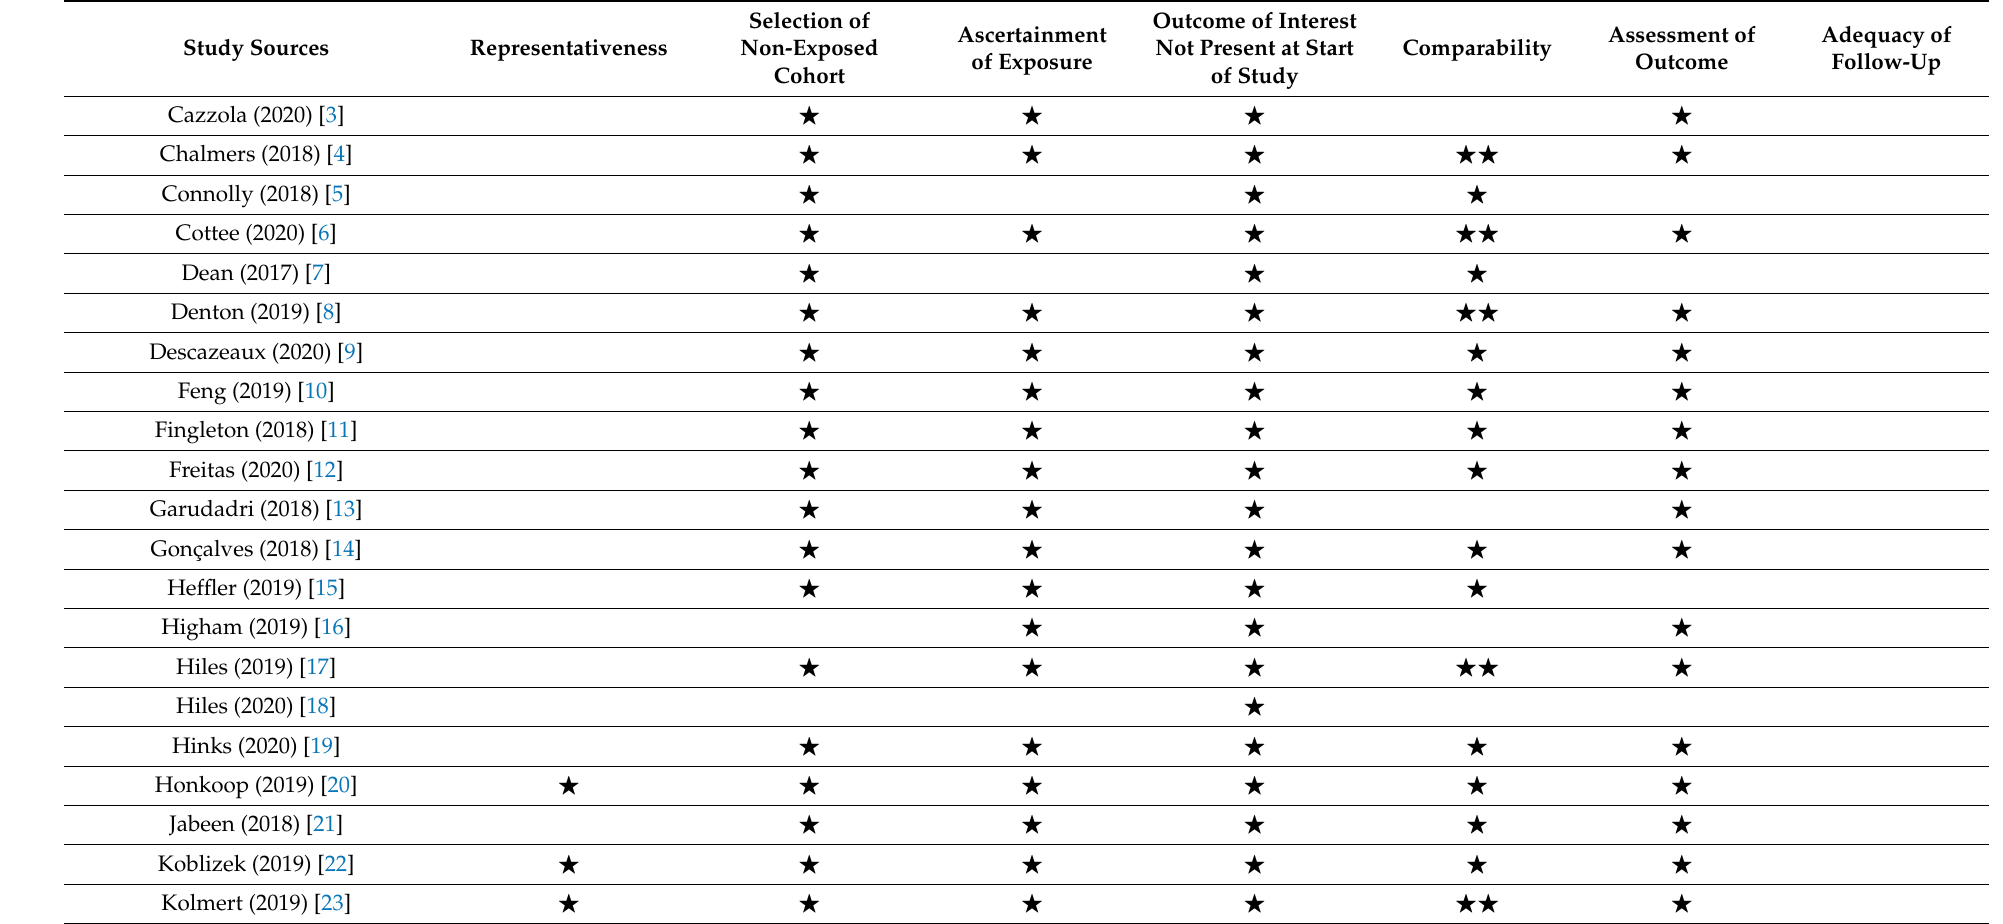
Table 1. Quality assessment using the Newcastle-Ottawa quality assessment scale